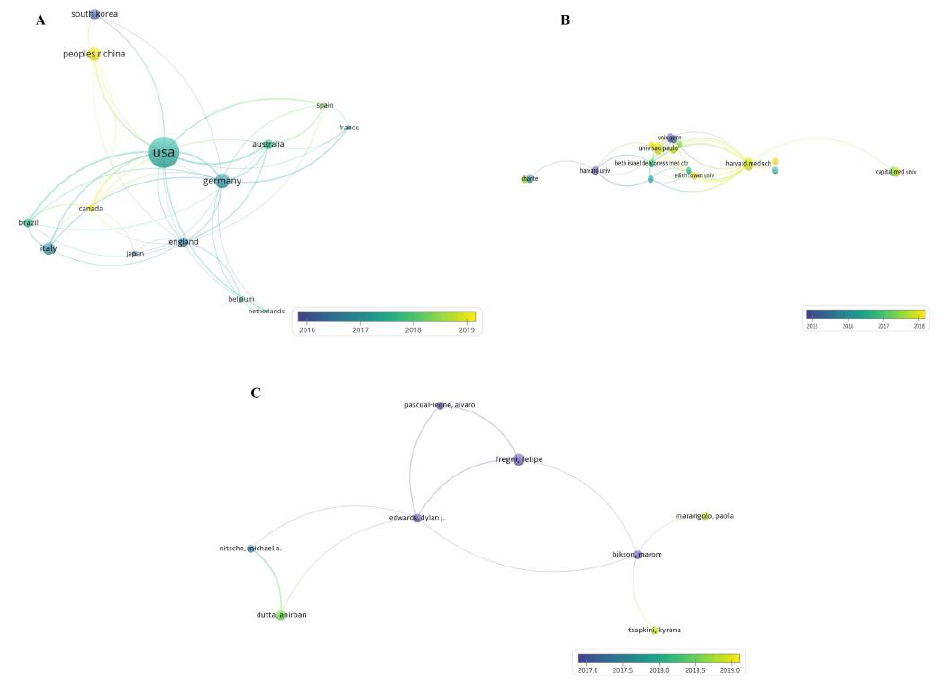
Figure 9. Collaboration maps of coauthorship analysis of countries ( A ), institutions ( B ), and authors ( C ).